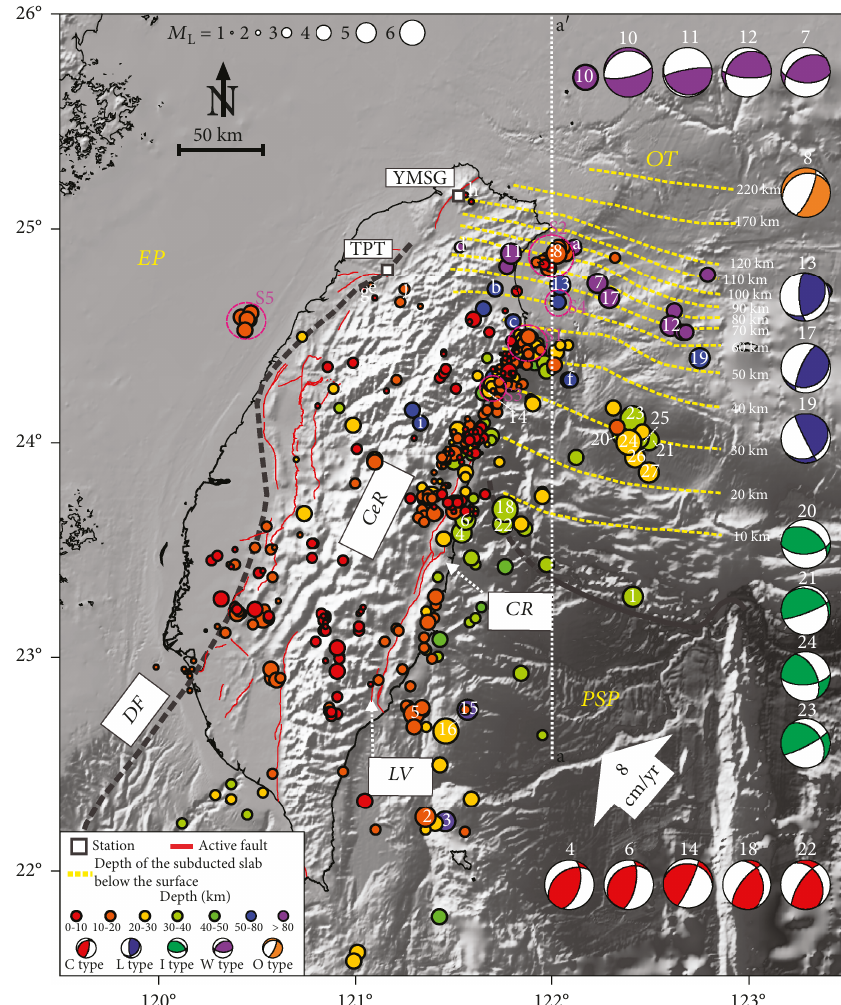
Figure 1: The simpli fi ed sketch of the regional map and principal tectonic structures around Taiwan shows that the Philippine Sea Plate (PSP) is moving northwest at 8 cm/yr towards the Eurasia Plate (EP). The circle symbols represent the earthquake epicenter with the focal depths corresponding to di ff erent colors from July 1, 2014, to June 1, 2015. The open square represents the location of the YMSG gamma ray station and the TPT radon station. The red lines indicate the active fault proposed by the Central Geological Survey of Taiwan [66]. Seismic events with magnitudes larger than fi ve and some speci fi c earthquakes are labeled and listed in Table 2. The yellow dashed lines indicate the isodepth contours between 10 and 220 km. OT=Okinawa Trough; CeR =central range; CR=costal range; LV=Longitudinal Valley; DF=deformation